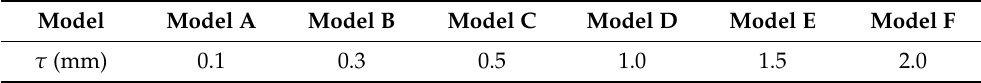
Figure 2. Schematic of tip clearance τ between blade tip and casing wall. Table 2. Six tip